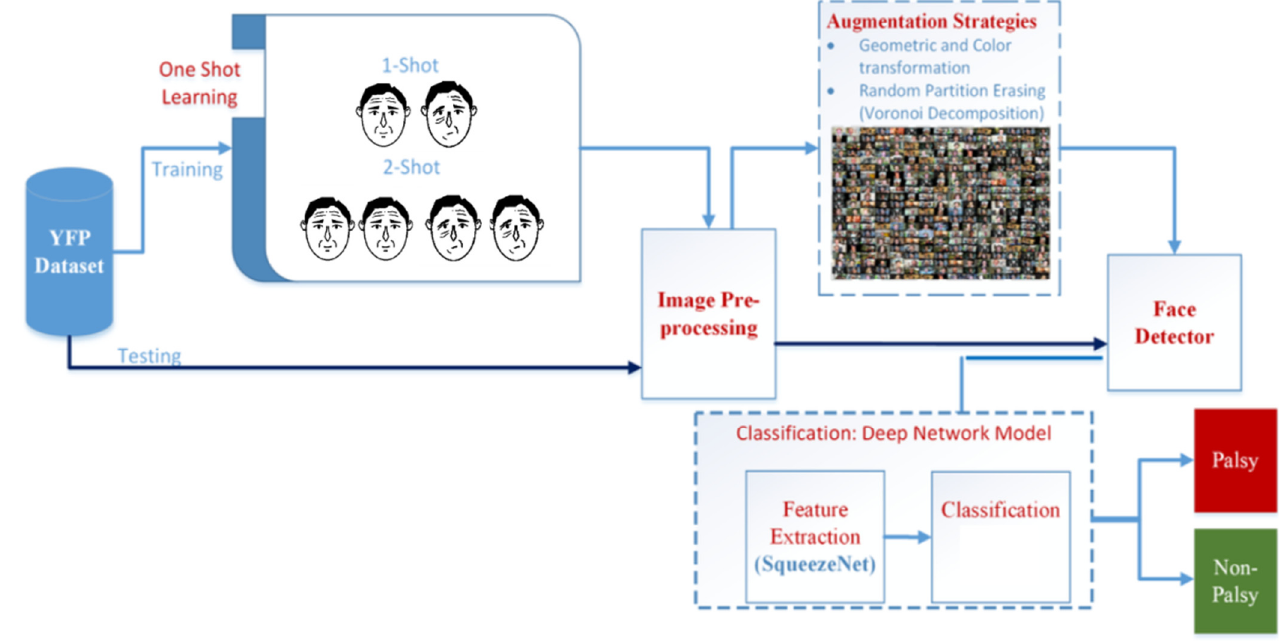
Figure 1. Flow diagram of our proposed methodology. YFP, Youtube Face Palsy.